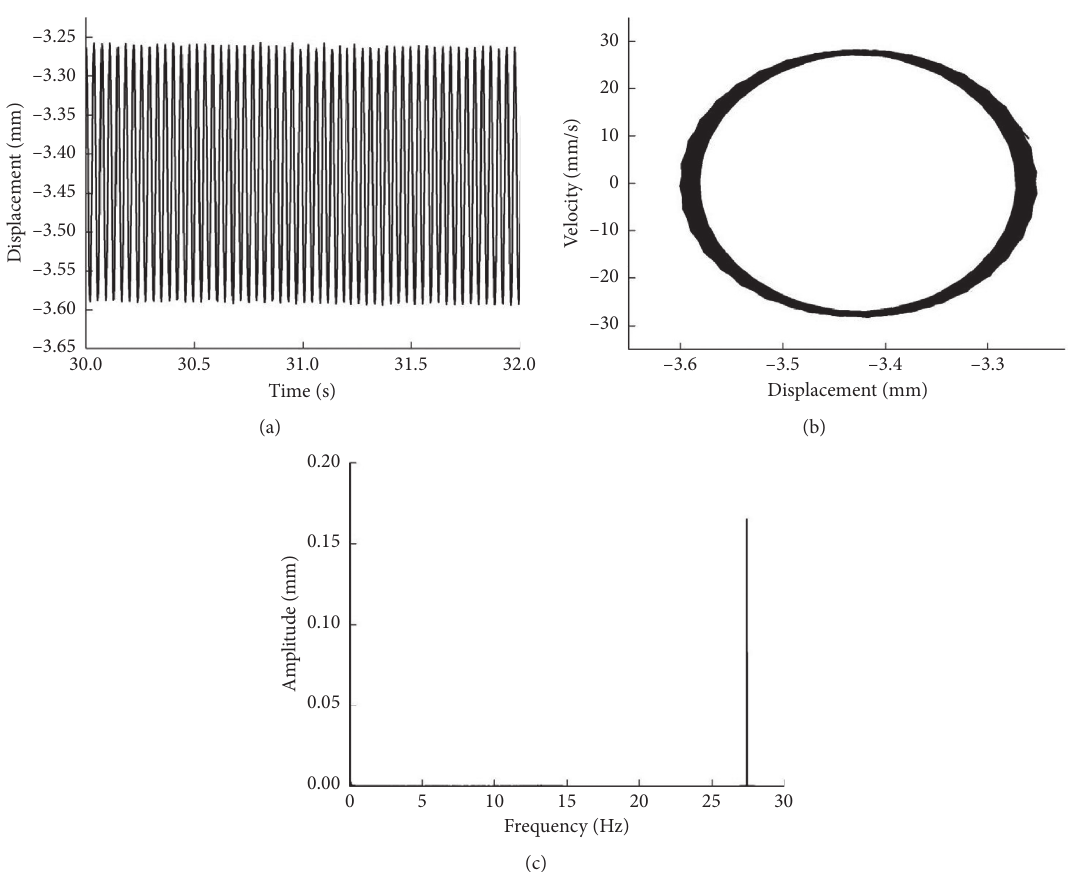
Figure 27: Period-1 motion of the system is obtained for the external excitation frequency Ω � 27 . 4 Hz: (a) waveform; (b) phase portrait; (c) amplitude